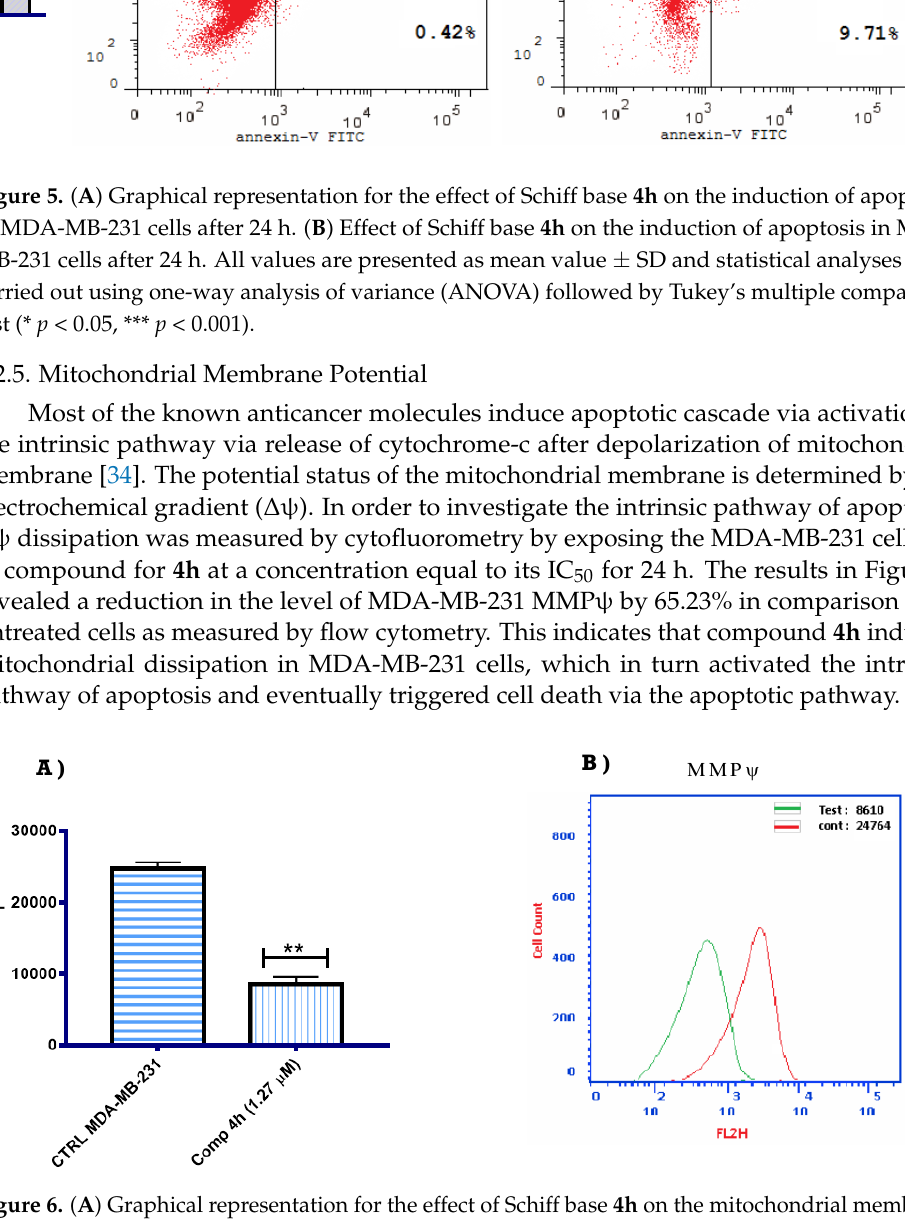
Figure 5. ( A ) Graphical representation for the effect of Schiff base 4h on the induction of apoptosis in MDA-MB-231 cells after 24 h. ( B ) Effect of Schiff base 4h on the induction of apoptosis in MDA-MB-231 cells after 24 h. All values are presented as mean value ± SD and statistical analyses were carried out using one-way analysis of variance (ANOVA) followed by Tukey’s multiple comparison test (* p < 0.05, *** p < 0.001).